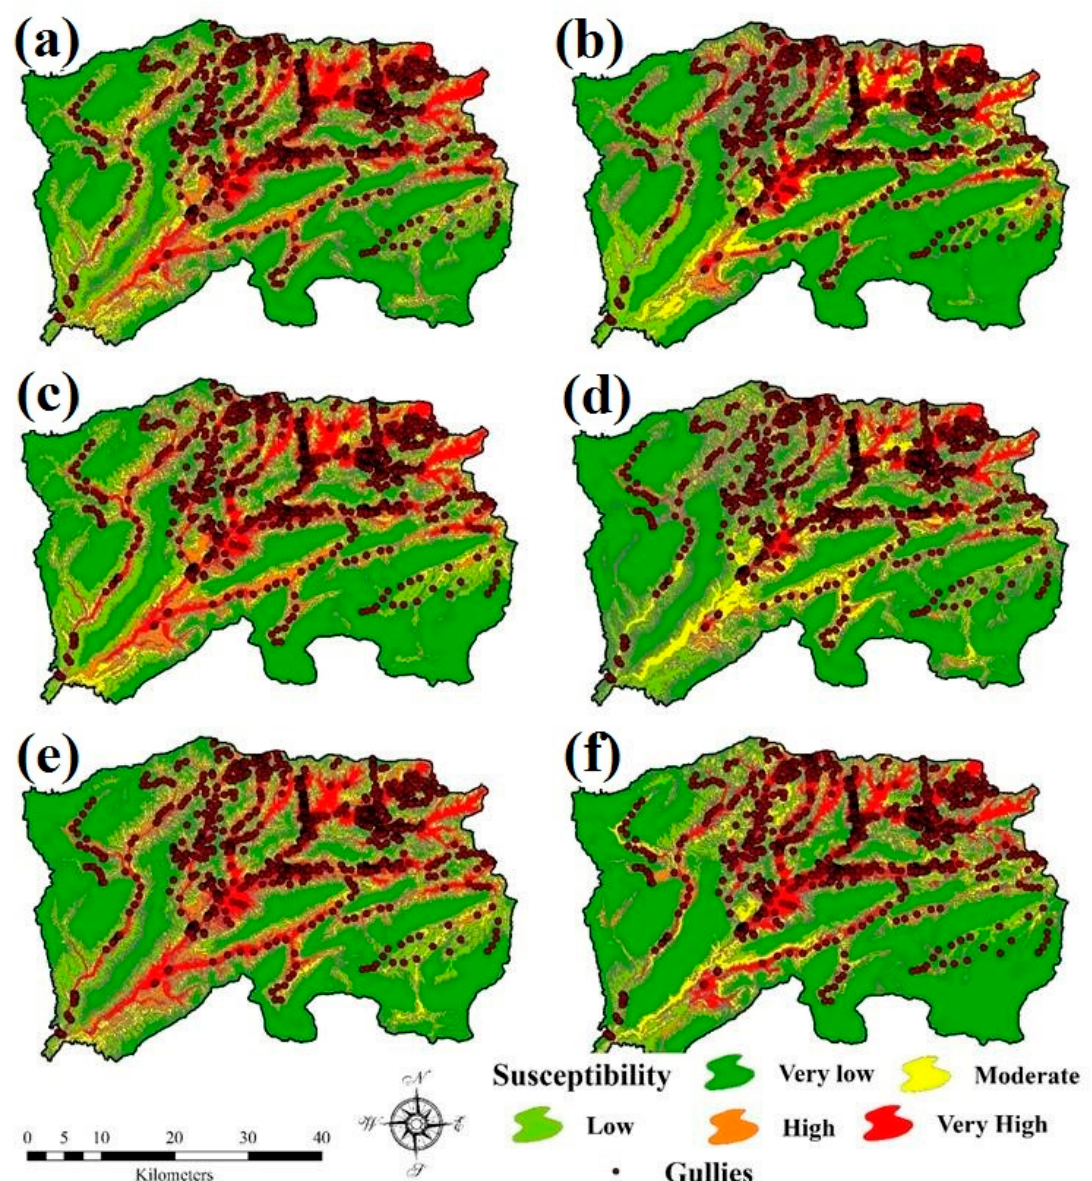
Figure 6. Gully erosion susceptibility maps using two-model ensembles: ( a ) GLM-MaxEnt, ( b ) GLM- ANN, ( c ) GLM-SVM, ( d ) MaxEnt-ANN, ( e ) MaxEnt-SVM, and ( f ) ANN-SVM. ( b ) GLM-ANN, ( c ) GLM-SVM, ( d ) MaxEnt-ANN, ( e ) MaxEnt-SVM, and ( f )